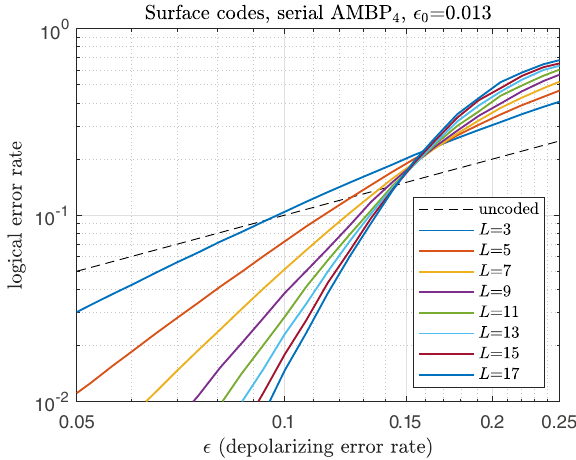
Fig. 8 The threshold performance of serial AMBP 4 on the surface codes. The dashed line represents the error rate without error- correction.